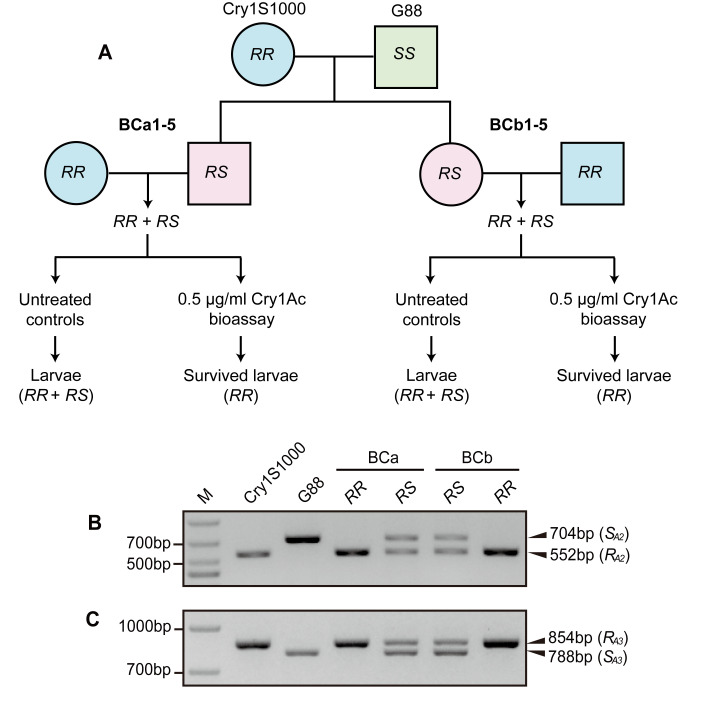
Genetic linkage analysis of RA2 and RA3 with Cry1Ac resistance.(A) Diagram showing the strategy for backcrossing and bioassays. A resistant female (Cry1S1000) was crossed with a susceptible male (G88) to produce F1 progeny. Two types of backcrosses were made between F1 and Cry1S1000: BCa1-5 families were produced by single-pair crosses between an F1 male and Cry1S1000 female, and BCb1-5 families were produced by single-pair cross between an F1 female and Cry1S1000 male. Only the resistant backcross progeny (RR) survived the discriminating 0.5 μg/ml Cry1Ac bioassay. (B,C) Genotyping of PxABCC2 (B) and PxABCC3 (C) in Cry1S1000 (RA2RA2 or RA3RA3) or G88 (SA2SA2 or SA3SA3) individuals, and their F1 progeny (RA2SA2 or RA3SA3) using AS-PCR.